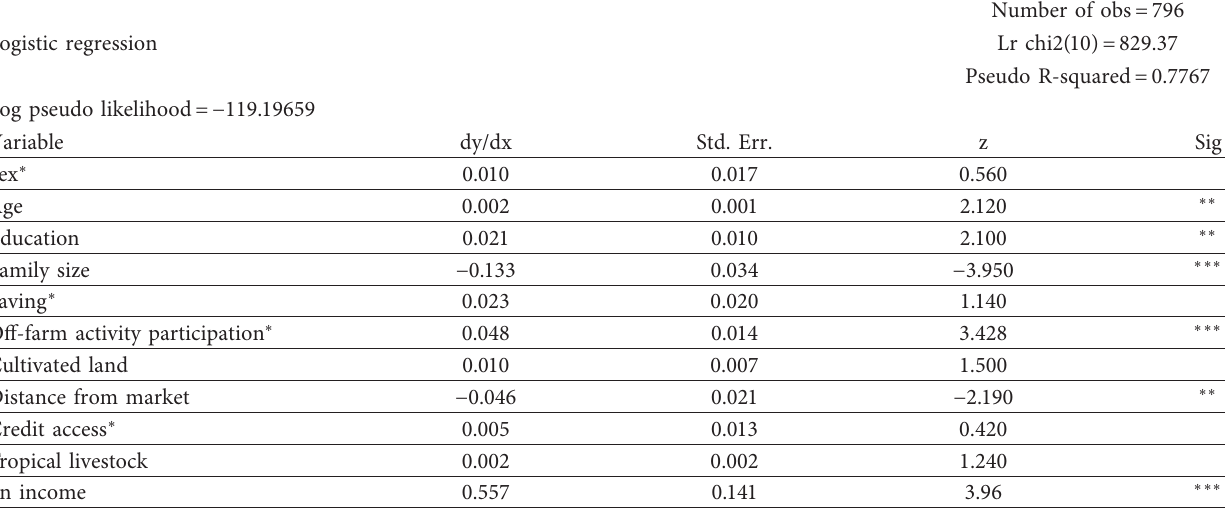
Table 5: Factors affecting the probability of household-level food security